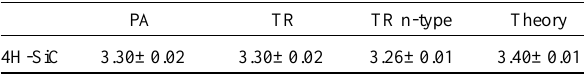
Table 1. Obtained values of the bandgap energies E using photoacoustic (PA) and transmission (TR) measurements and theoretical (Theory)